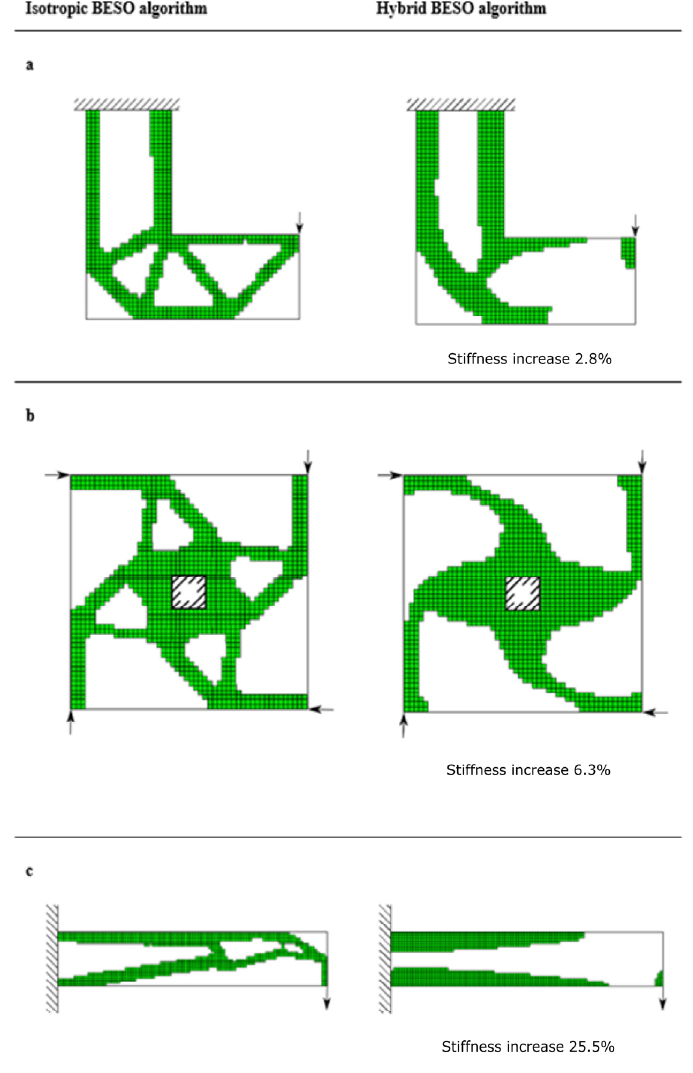
Figure 17. Results of isotropic and hybrid anisotropic topology optimizations for the examples presented in Figure 10. All examples show that taking into account the stiffness of sFRP and the anisotropy of cFRP during optimization leads to an increase in the resulting stiffness of the structure compared to an isotropic optimization. The amount of increase depends strongly on the particular load case. ( a – c ) show that hybrid optimization does not always result in a continuous structure between load introduction and fixed